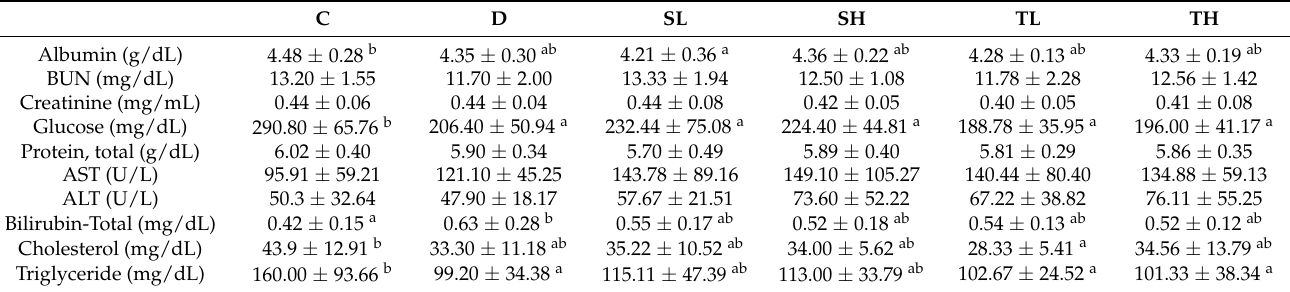
Figure 3. Effect of water extract of tempeh on the proliferation of Caco-2 cells. Table 1. Serum biochemical parameter in rats of SD rat gavaged with soybeans or tempeh for 12 weeks.